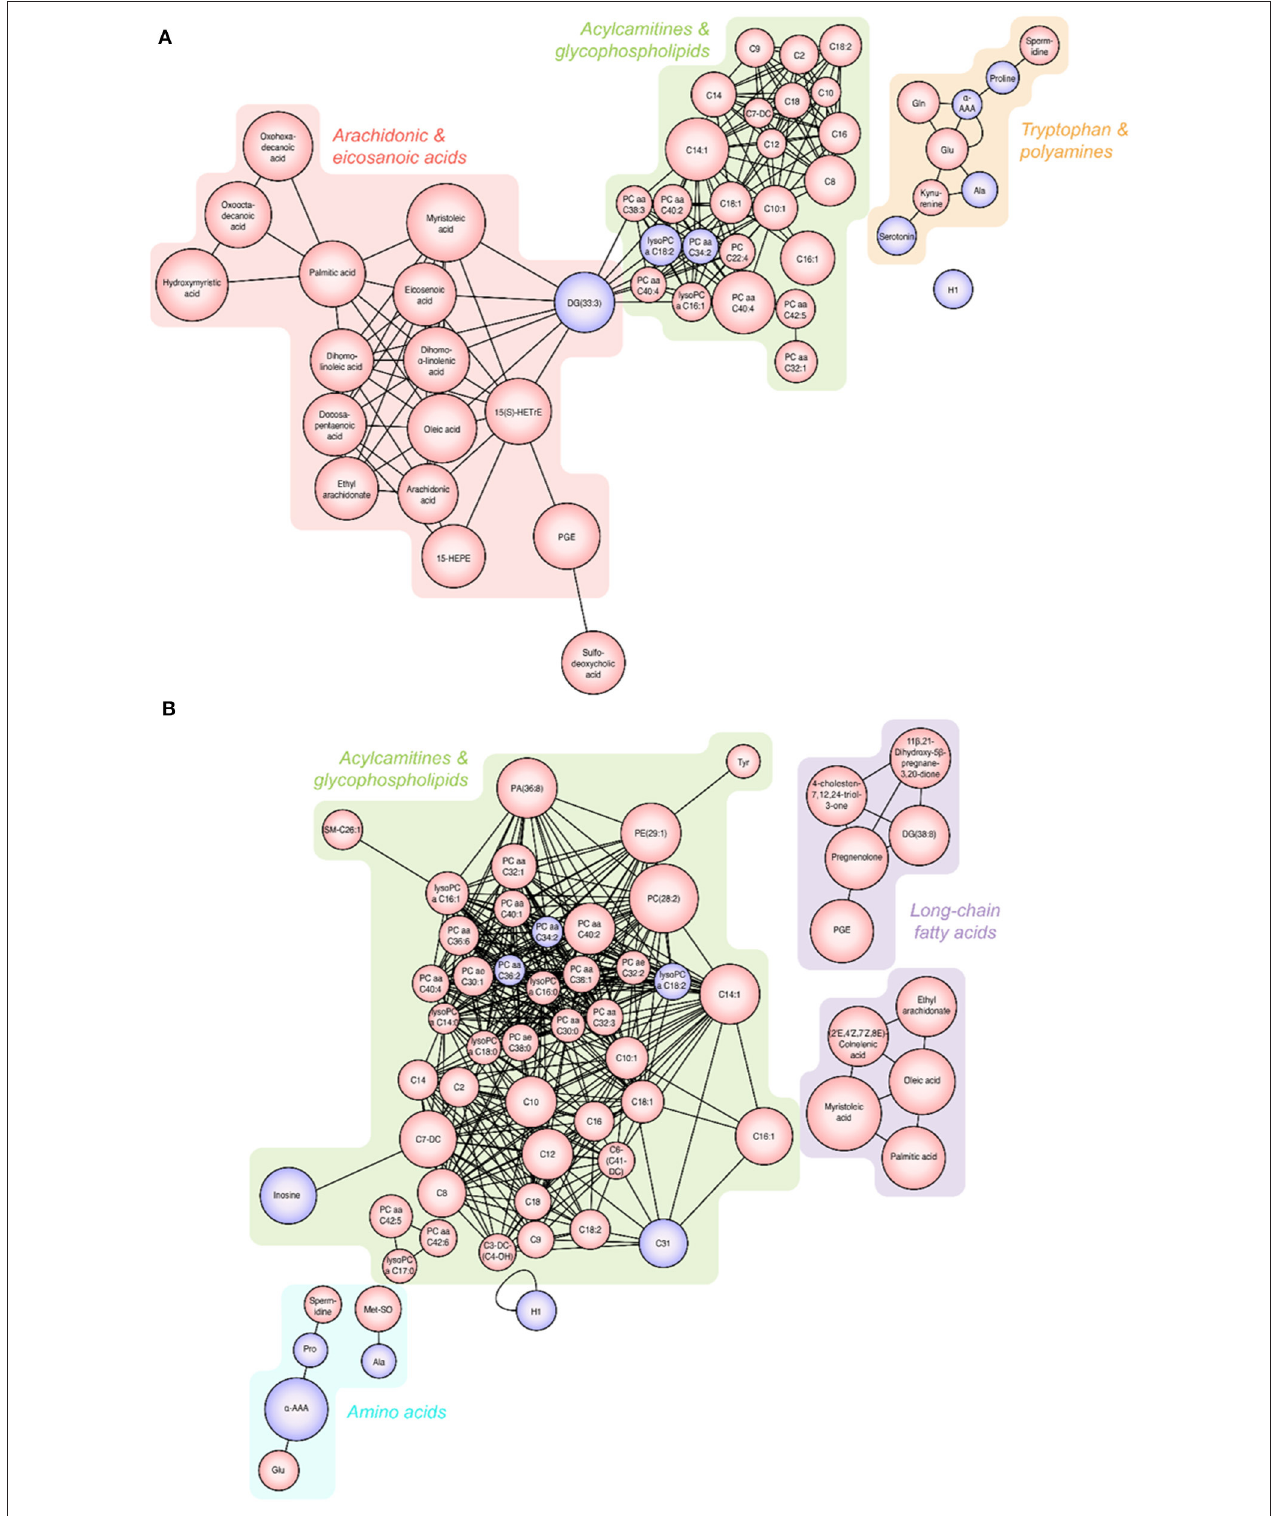
FIGURE 3 | Changes in metabolites seen in patients with T-COPD and S-COPD. (A) Significantly altered metabolites were observed between the NC and T-COPD groups. (B) Significantly altered metabolites were observed between the NC and S-COPD groups. The size of the circle indicates the relative fold change compared to the NC group. The red circle represents increased levels and the purple circle represents decreased levels of metabolites in patients, compared to healthy controls. NC, normal control; T-COPD, TB-associated COPD; S-COPD, smoking-associated COPD.